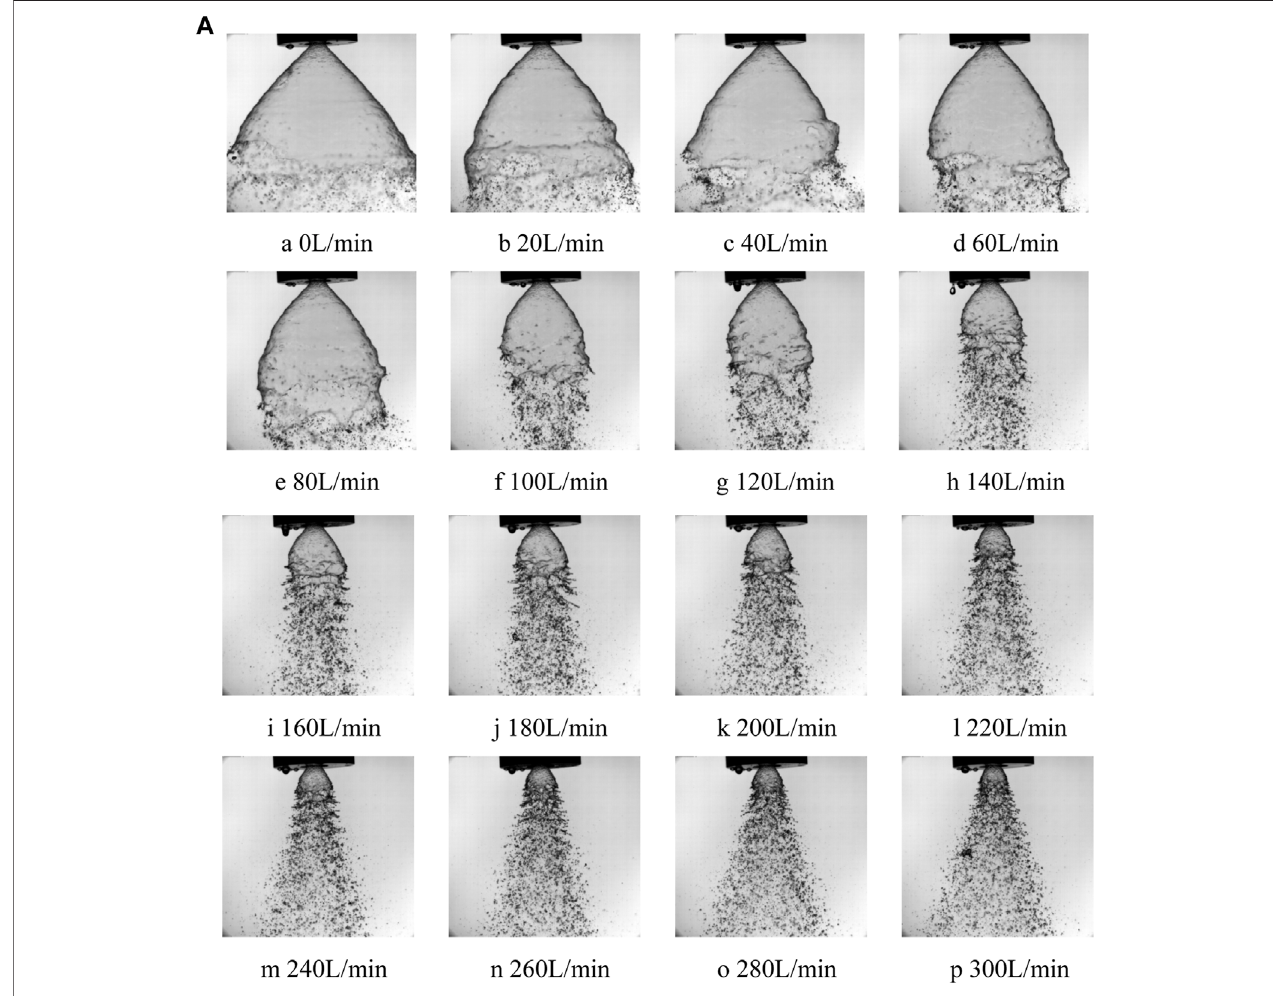
FIGURE3|(A) Impactsofthegaseous fl owrateontheatomizationmorphology,W-1injector. (B) Impactsofthegaseous fl owrateontheatomizationmorphology, W-2 injector. (C) Impacts of the gaseous fl ow rate on the atomization morphology, W-3 injector.